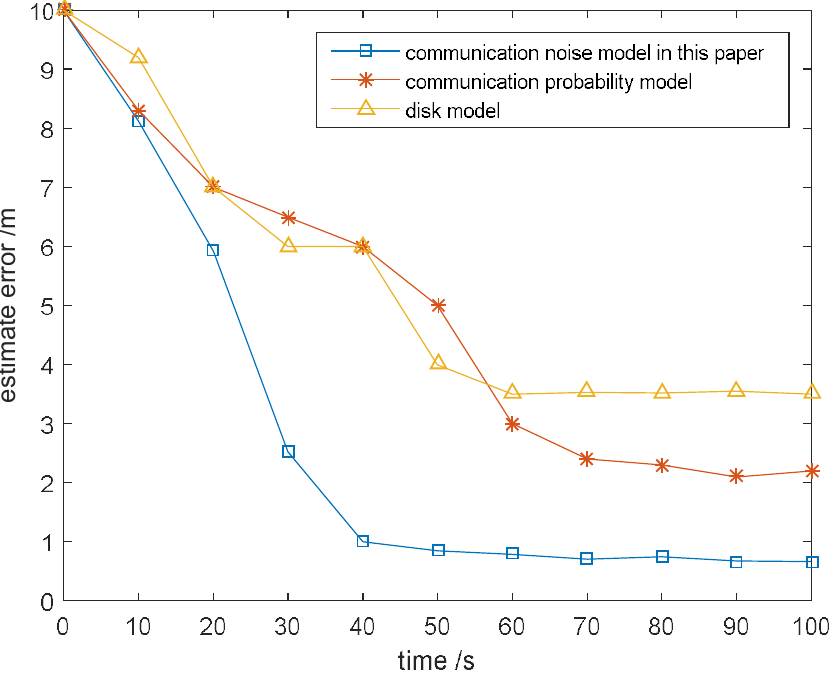
Figure 8. The average estimate error compared with other methods in presence of interference.